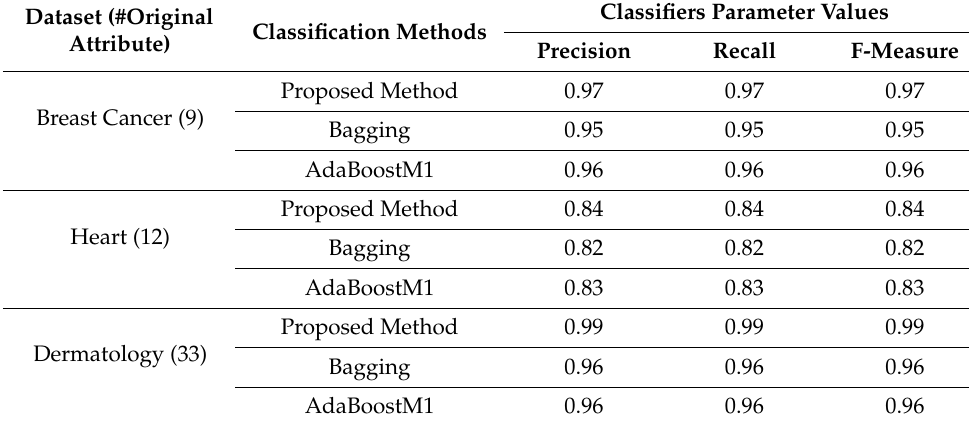
Figure 7. Accuracy for Rice disease dataset2 in the big data environment. Table 2. Comparative Classification values for other disease Table 1. Comparative Classification accuracy for other disease datasets.